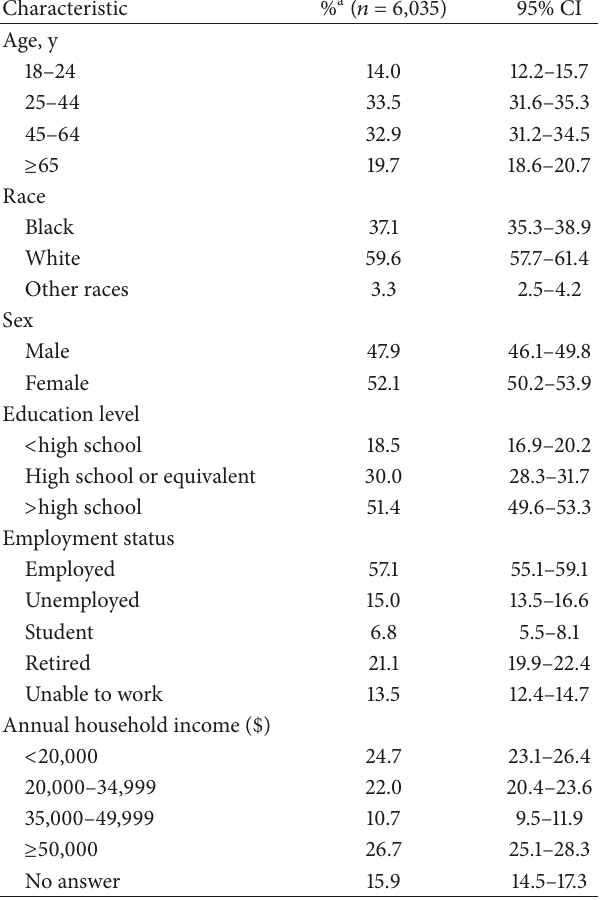
Table 1: Sociodemographic characteristics of Mississippi adults, Behavioral Risk Factor Surveillance System,